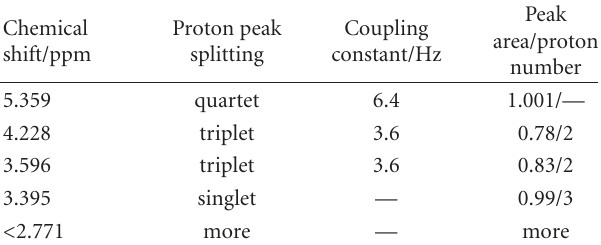
Table 5: P 1 P H NMR data of rapeseed oil